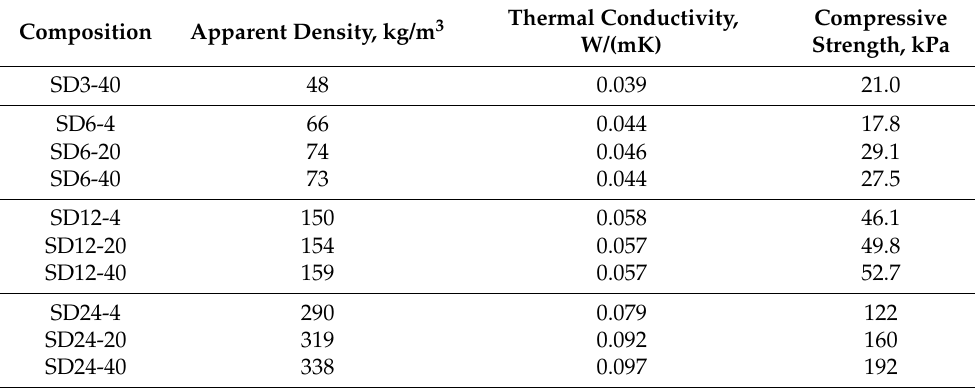
Table 2. Properties of EPS and gypsum samples for curing under pressure method.